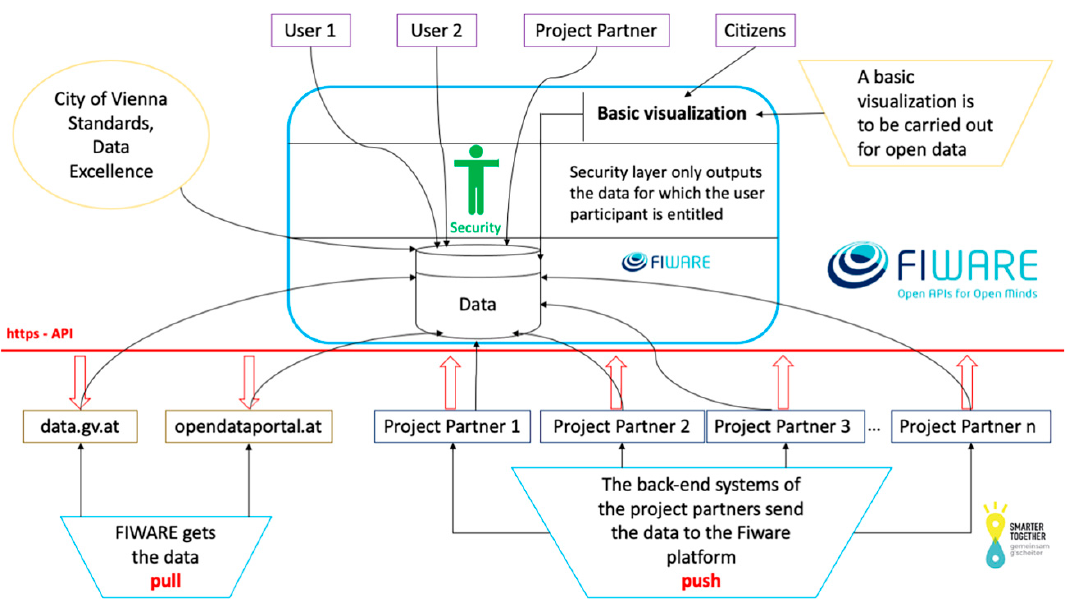
Figure 3. Overview of the Vienna Data Platform and central data management system [16].